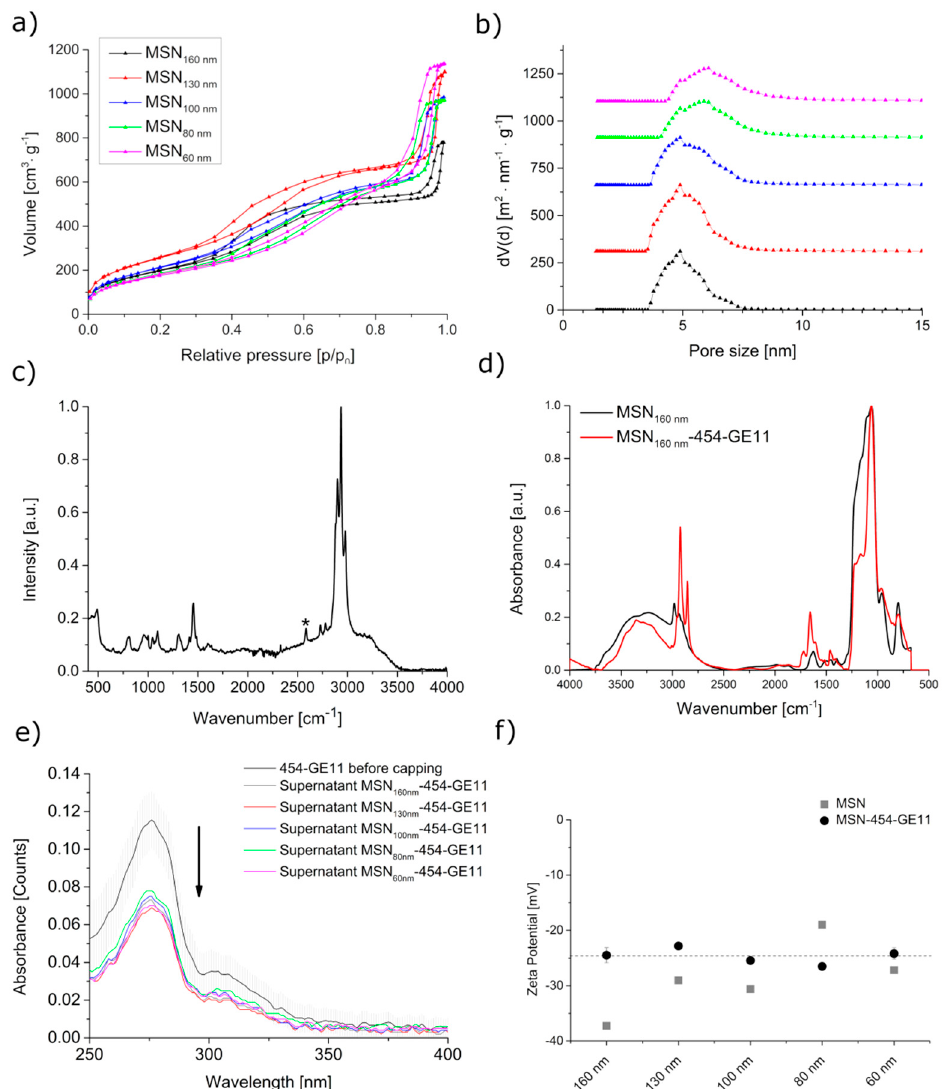
Figure 3. Characterization of MSN and MSN-454-GE11. ( a ) Nitrogen sorption isotherms and ( b ) corresponding pore size distributions. For clarity, the pore size distribution curves in panel b are shifted along the y -axis. ( c ) Raman spectrum of MSN160 nm. The signal at 2580 cm − 1 (indicated by *) indicates the presence of thiol groups. ( d ) IR spectra, ( e ) UV VIS spectra of the capping solution before capping (black line) and the supernatants after capping, and ( f ) zeta potential measurements of MSN and MSN-454-GE11 at pH = 7.3.